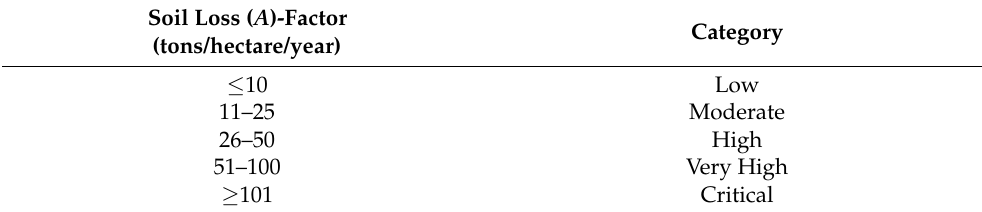
Table 7. Soil loss class